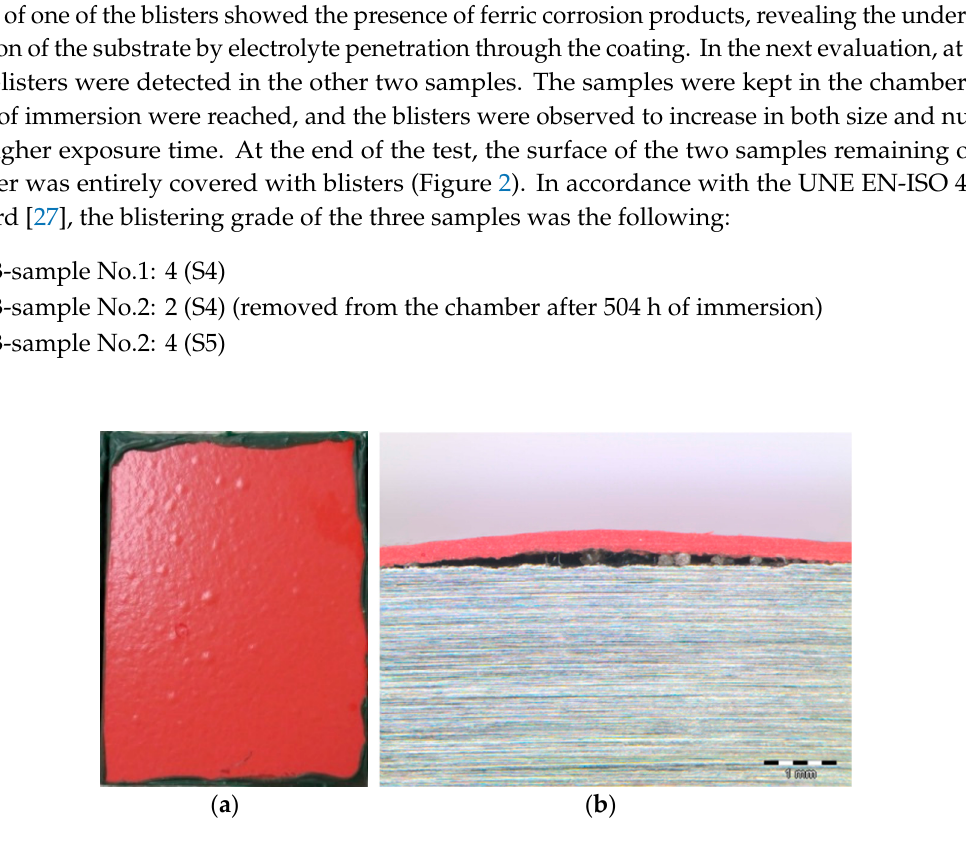
Figure 4. Surface state of sample No.2 of the C3 coating showing blisters after 504 h of immersion ( a ) and micrograph of the ferric corrosion products formed under the blister ( b